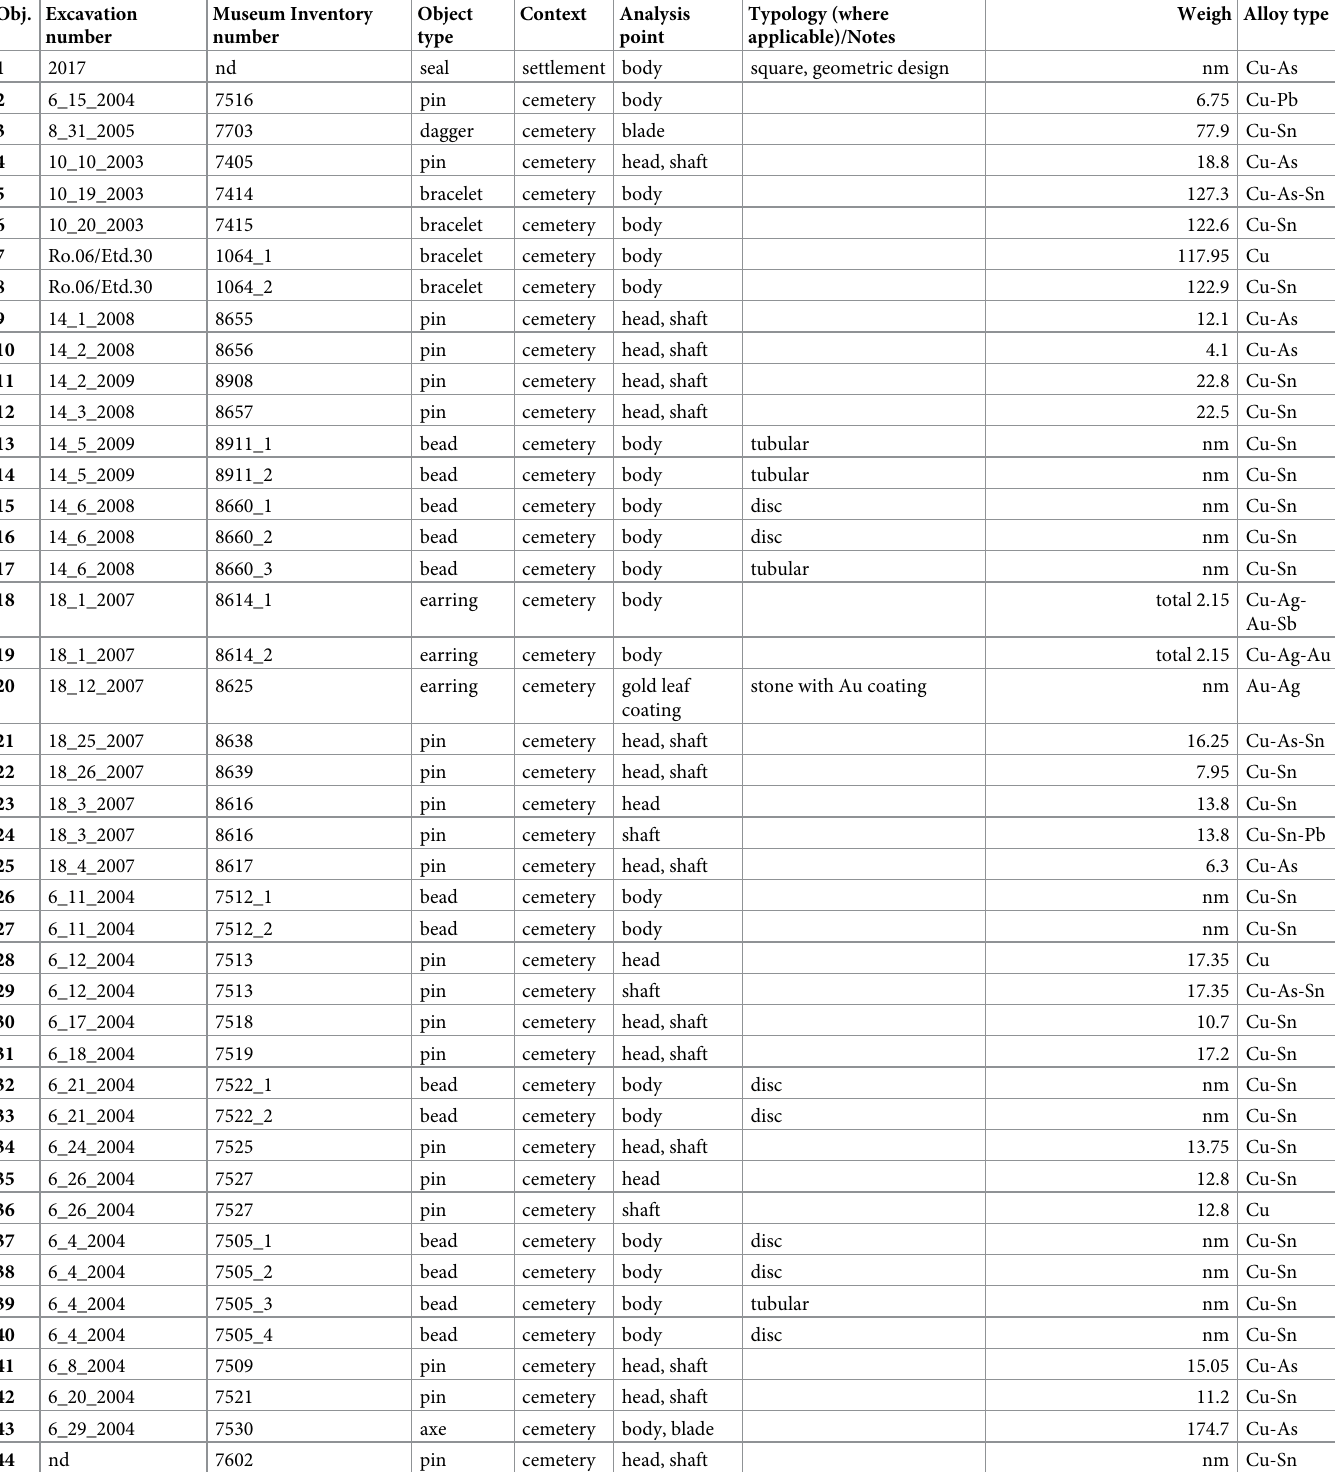
Table 2. The inventory numbers (excavation and/or museum numbers), object types, analysis point(s), typologies (where applicable), weighs, and alloy types of the Resulo ğ lu metal artifacts. (nd: not determined or inventory number not assigned; nm: weight not measured). Obj. Excavation